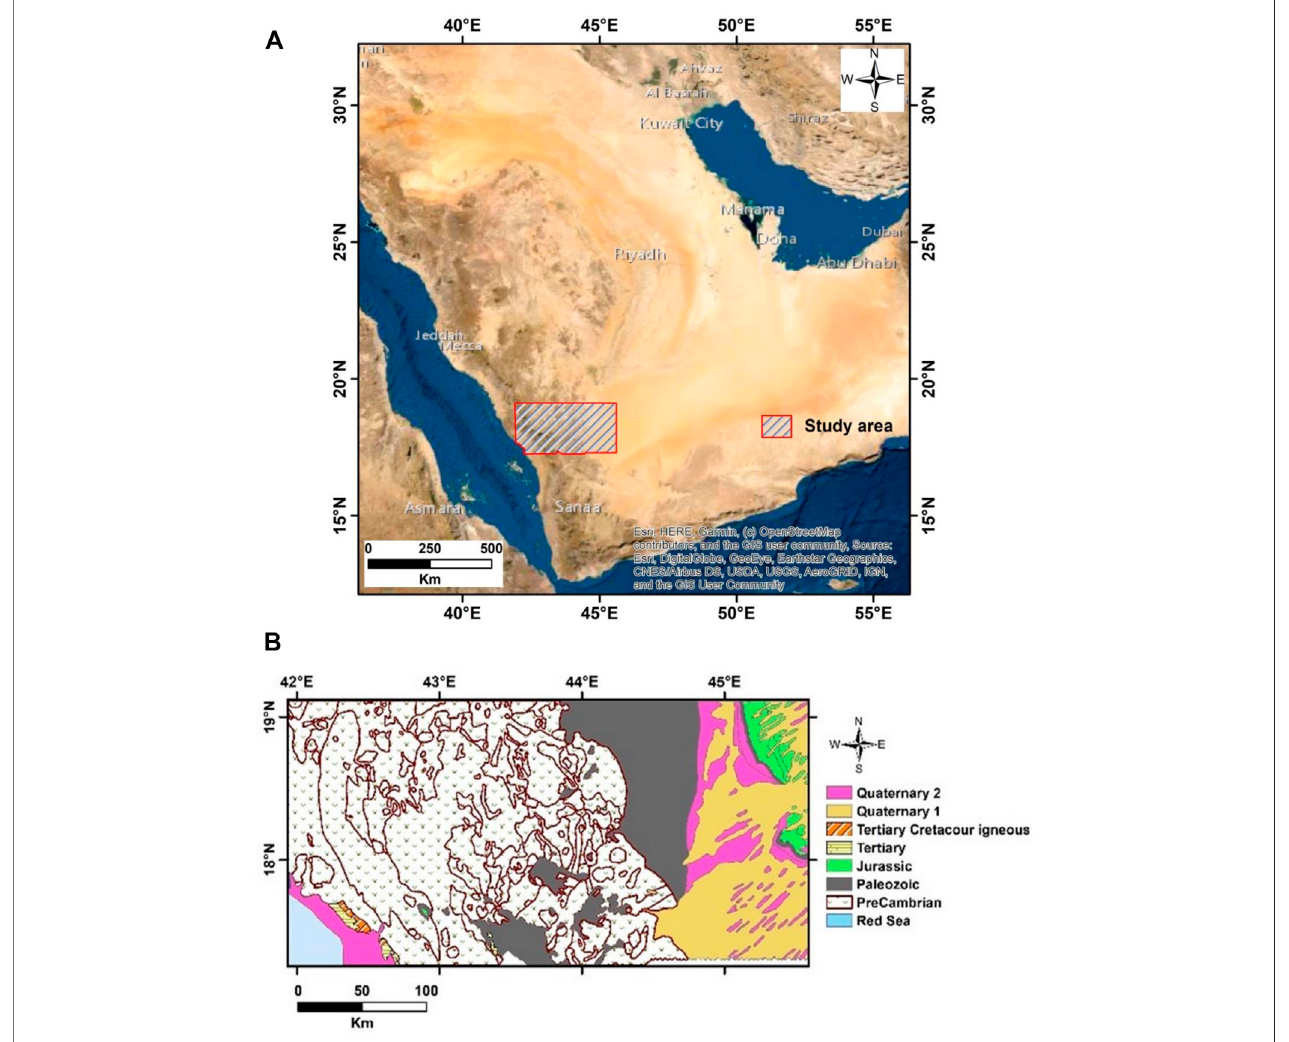
FIGURE 1 | (A) the Location map of the study area, and (B) its